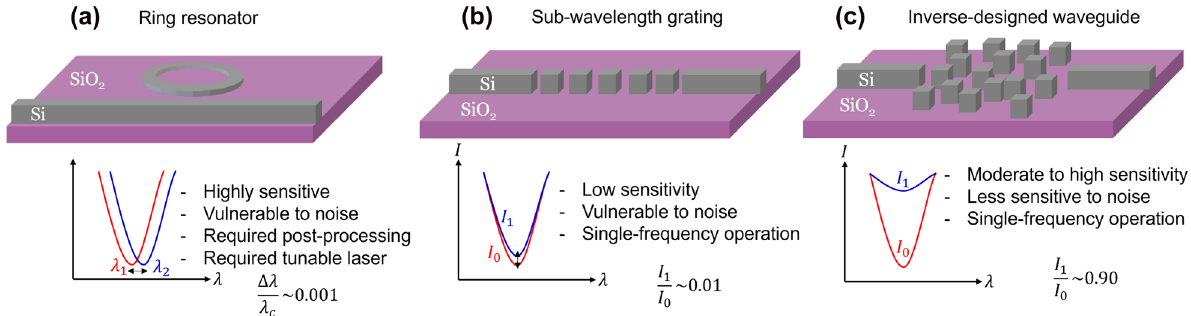
Figure 1: Schematic figures showing the three types of integrated Si optical biosensors compared in this work. (a) Ring resonator-based biosensor offers a highly sensitive detection of small refractive index change through the shift of the resonance wavelength. However, this approach may be vulnerable to noise which could be caused by the presence in the sample of any other material than a target molecule. (b) Sub-wavelength grating-based biosensor which has larger surface area compared to straight waveguide. The incident light passes through the grating once, thus it shows low sensitivity compared to high-quality factor design, (c) inverse-designed waveguide-based biosensor which shows moderate to high sensitivity and is less affected by noise. This scheme also allows a single frequency operation which could lead a development of an ultra-compact and affordable optical